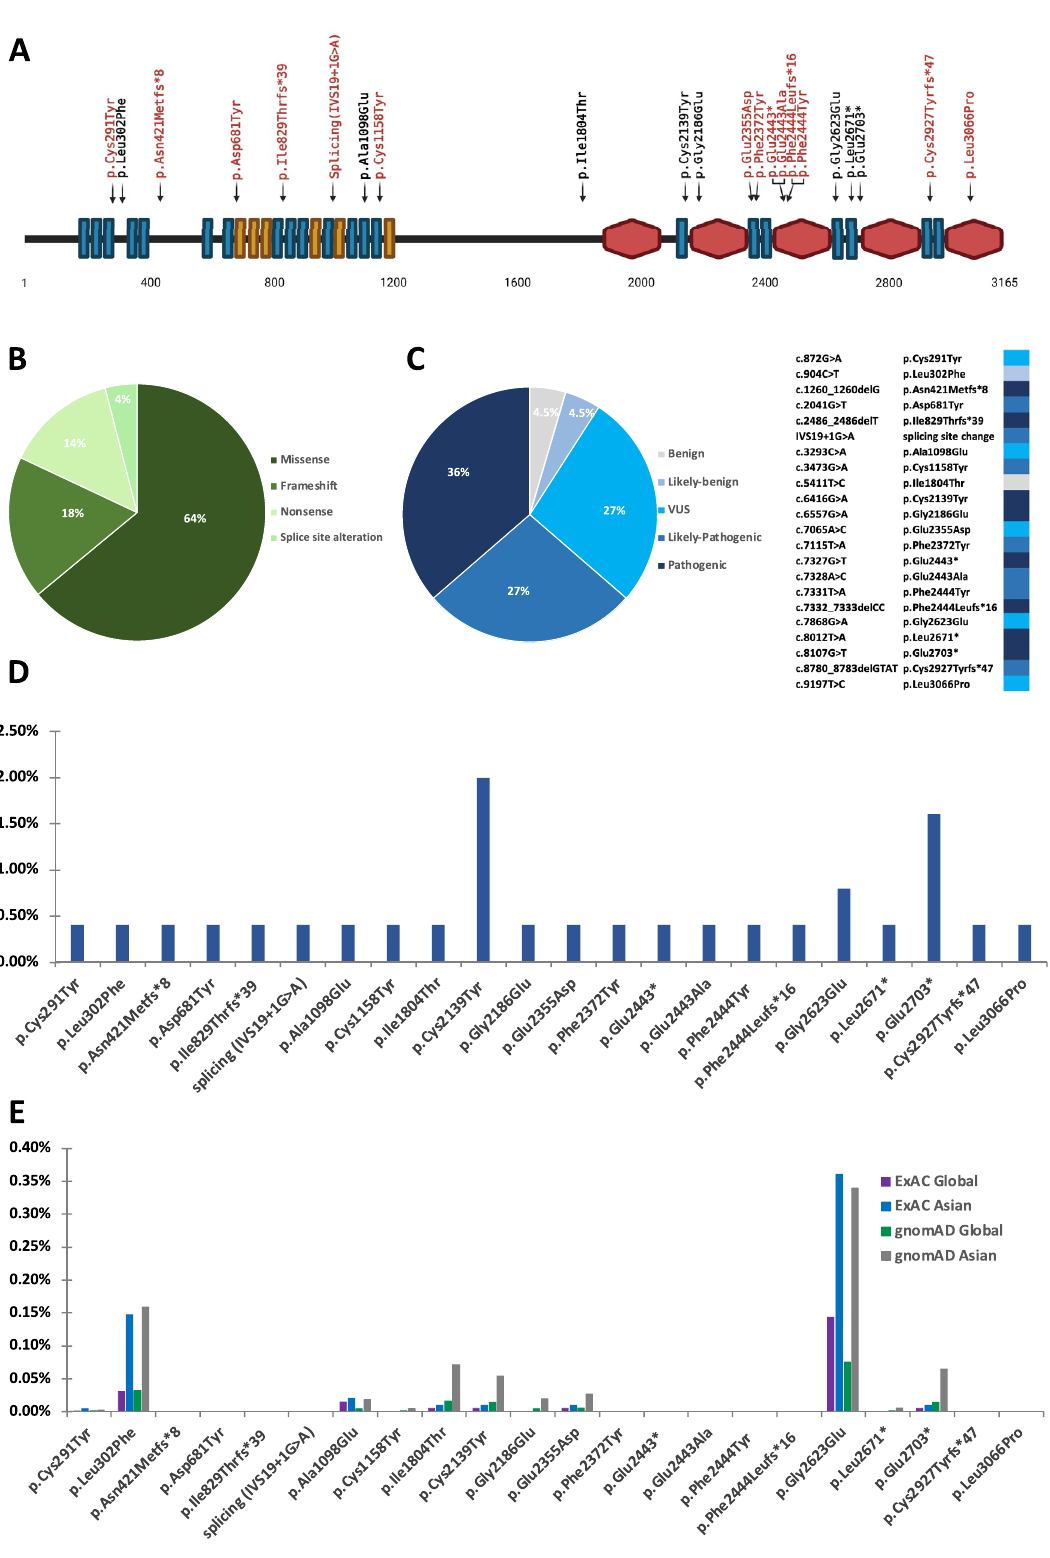
Figure 2. Variants in the EYS gene. ( A ) Schematic diagram of the human EYS protein (isoform 4, accession: NM_001292009.2), with 21 EGF-like (blue rectangles), 6 EGF-like calcium-binding (red rectangles), and 5 Laminin-G domains (red hexagons). Novel and reported variants are depicted in red and black, respectively. Types ( B ) and classification ( C ) of the detected variants (N = 22). Allele frequency of the detected variants in this cohort ( D ) and in the general population from ExAC and gnomAD ( E